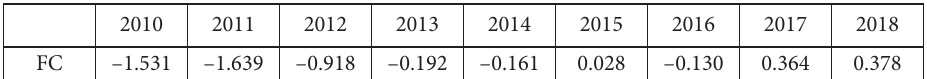
Table 5. Financing constraint during 2010–2018